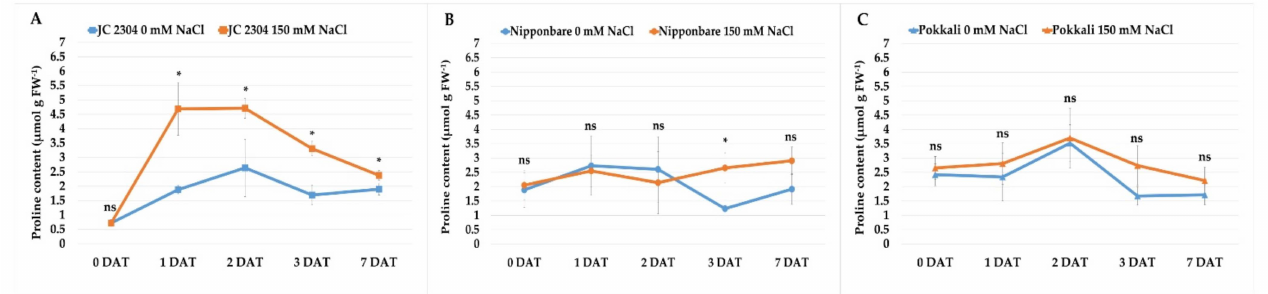
Figure 1. Effects of salinity stress (150 mM NaCl) on free proline content of wild and cultivated rice at the seedling stage. ( A ) Wild rice O. australiensis JC 2304. ( B ) Cultivated rice O. sativa cultivar Nipponbare. ( C ) Cultivated rice O. sativa cultivar Pokkali. Data are means ± SE (n = 3). Asterisks indicate the significant difference ( p ≤ 0.05), ns-not significant, based on the Student t -test between salt-stressed and non-stressed counterparts. DAT—day after treatment. FW—fresh